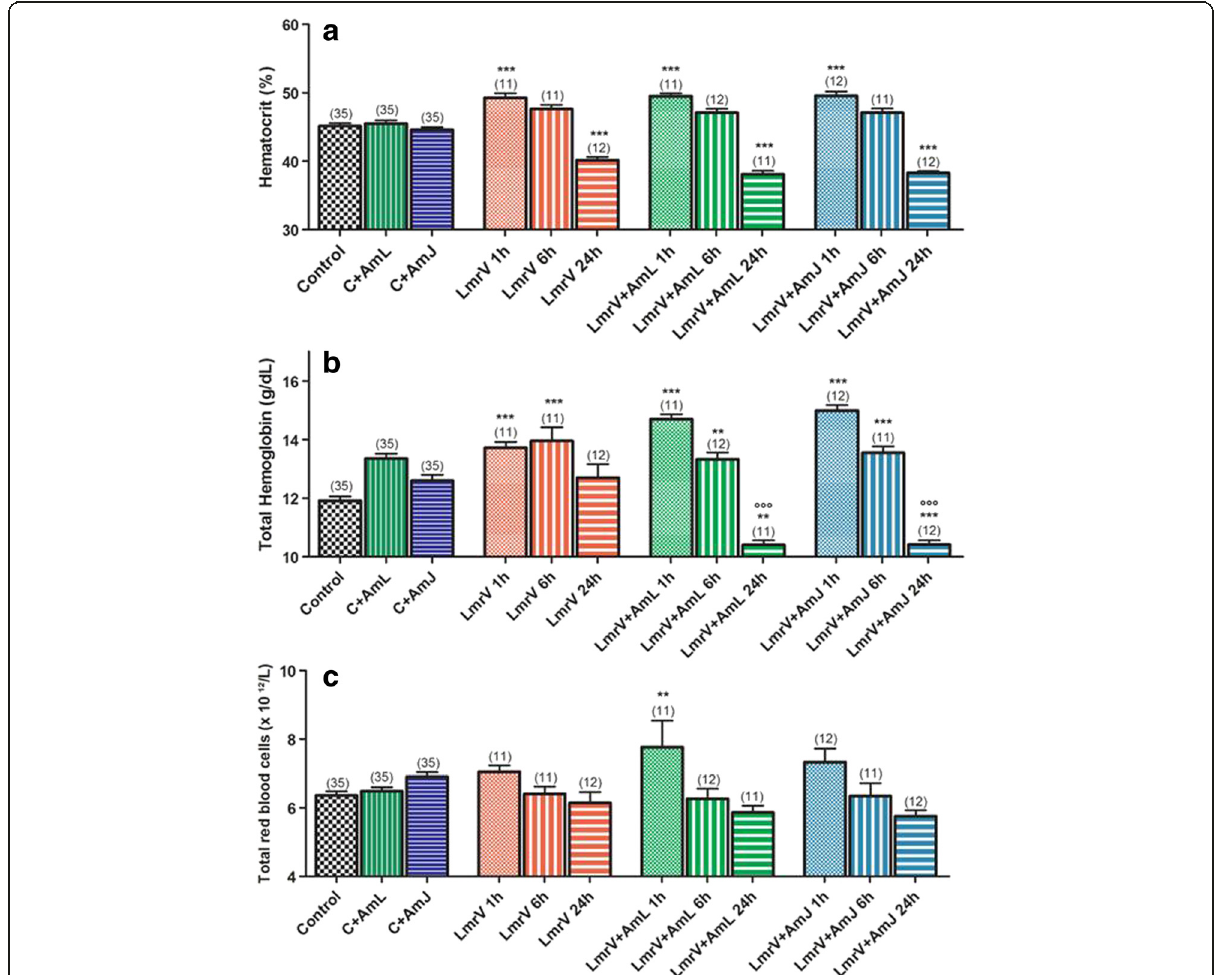
Fig. 2 a Hematocrit, b total hemoglobin concentration, c total red blood cells count in whole blood of male Wistar rats injected with 3 mg of Lachesis muta rhombeata venom, at 1, 6 and 24 h after envenomation (LmrV) and with their respective treatments with aqueous extract of Annona muricata L. leaves (LmrV + AmL) or Annona muricata L. juice (LmrV + AmJ). The numbers above the columns represent the number of animals used in each test. *** p < 0.001, ** p < 0.01 compared to control group. °°° p < 0.001 compared to the envenomation group